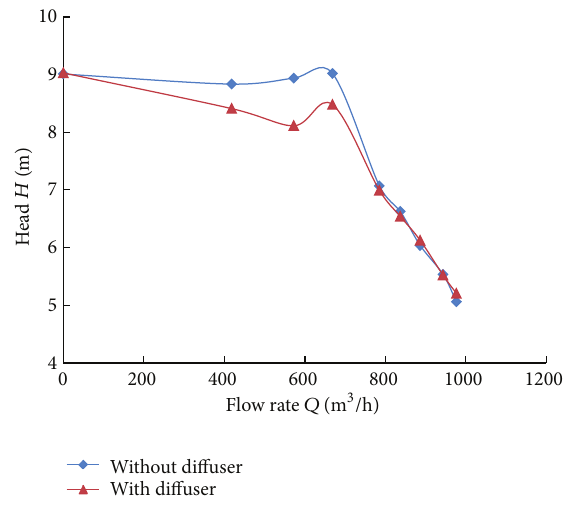
Figure 14: Comparison of performance curve when the pump is with and without